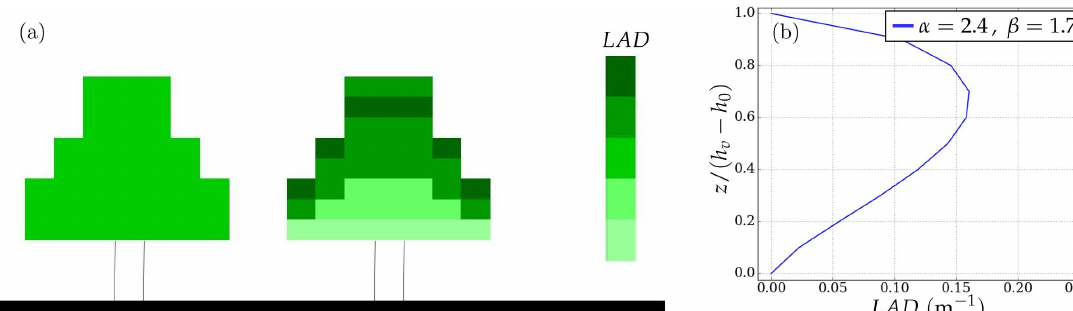
Figure 4. ( a ) A mock-up illustration of the two different leaf area density (LAD) distributions used in the study: In the low level of detail approach, every grid cell within a tree contains a fixed mean LAD value. In the higher level of detail model, each grid column respects the prescribed vertical profile processed from a point cloud dataset ( b ). The starting height of the tree crown h 0 = 4 m originates from a city policy that dictates that all branches below 3–4 m are trimmed. The two approaches always (cid:82) h v LAD dz yield the same LAI = h 0